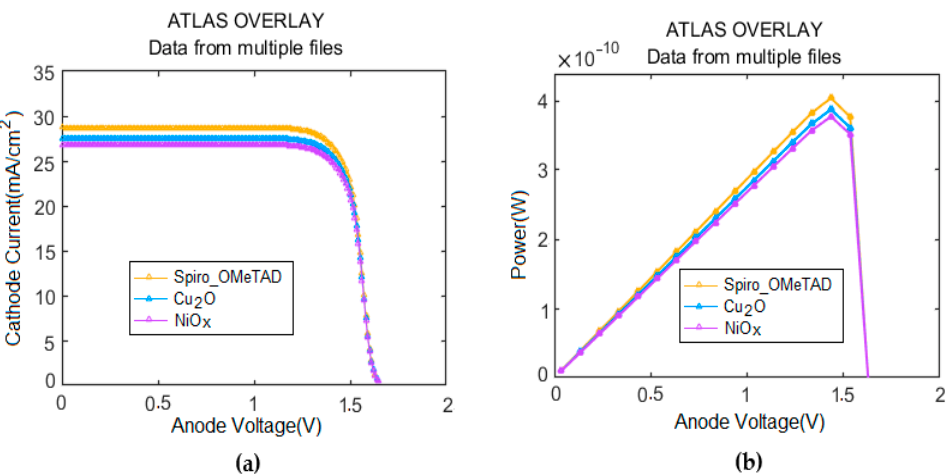
Figure 9. ( a ) Effect of three different HTMs on the current and voltage of the inverted planar PSC using ZnO as ETM, and ( b ) a comparison of power generation curves for three different HTMs in the inverted planar PSC. Table 4. Performance parameters of the p-i-n perovskite solar cell structures for three HTMs .